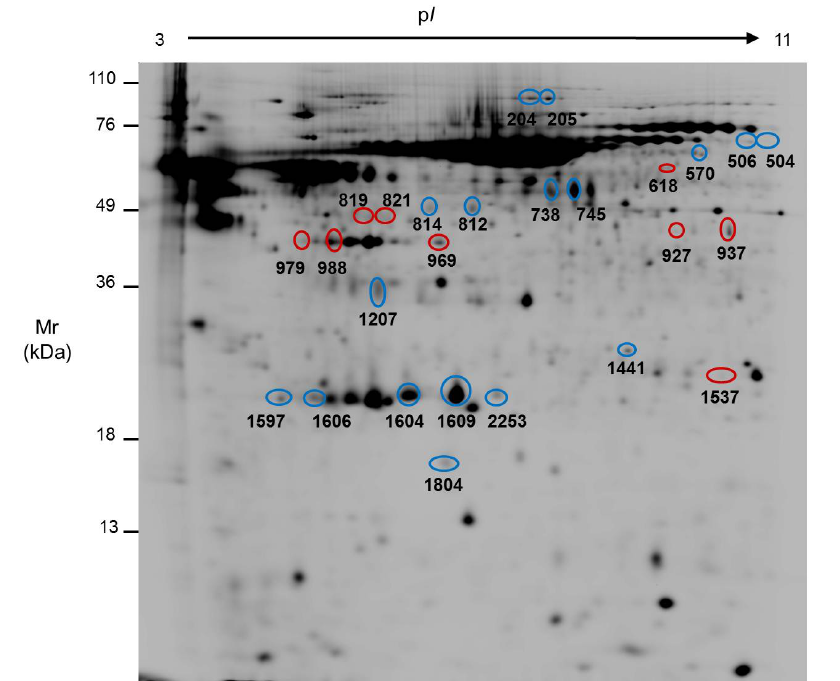
Figure 3. Representative 2-D map where the spots with significant variation due to Caco-2 differentiation identified by MS are highlighted. The spot numbers correspond to those shown in Table 2. Blue circles indicate higher expression and red circles lower expression in undifferentiated (tumor-like) cells. Mr: relative molecular mass; pI: isoelectric